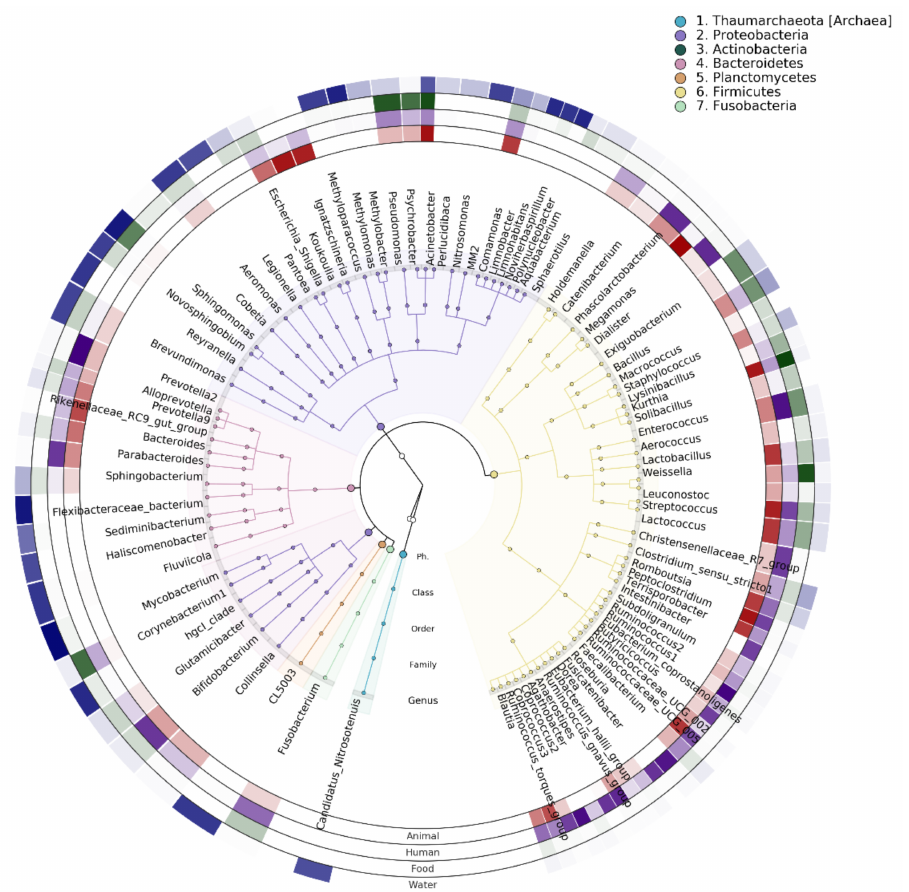
Figure 7. Cladogram depicting the relative abundance of the bacterial genera detected in the different sample types. Only genera with a mean relative abundance of >0.5% in at least one of the sample types were included. Background and branch colors reflect the different phyla. The color density of the four outer rings reflects the relative abundance (arcsine square root transformed) of the genera in the different sample types (with opaque color indicating a relative abundance of 1 and fully transparent indicating a relative abundance of